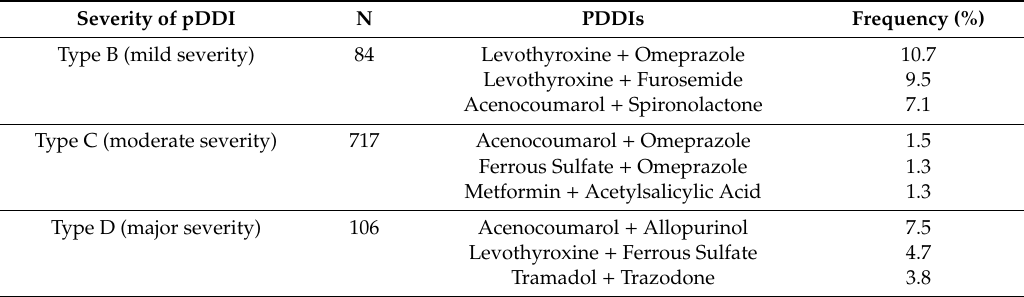
Table 4. Most frequent potential drug–drug interactions (pDDIs) by severity